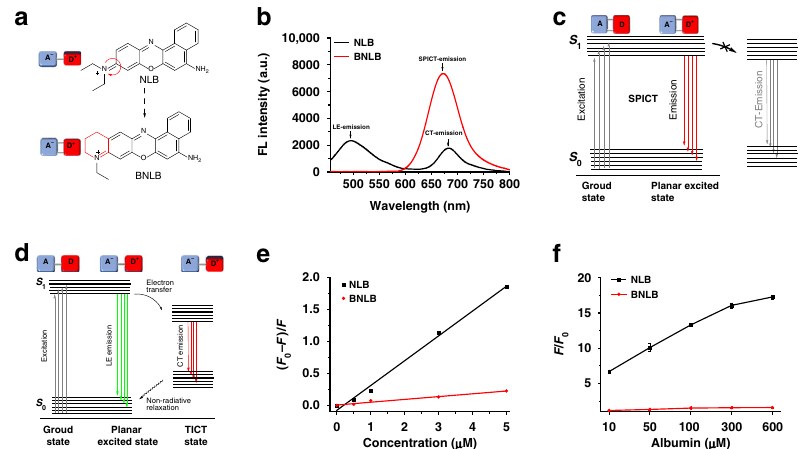
Fig. 3 Design of “ pocket-escaping ” NIR dyes to avoid albumin binding. a The chemical structure of BNLB. b Fluorescence emission of NLB (black) and BNLB (red) in PBS buffer solution (pH 7.4, 10 mM) with an excitation at 420 nm. c , d Jab ł o ń ski diagram showing the emission mechanism of BNLB and NLB. e Binding af fi nities of BNLB (red) and NLB (black) to albumin ( n = 3 independent experiments). f Fluorescence enhancement of NLB (black) and BNLB (red) with the addition of albumin (10 − 600 µ M). Data are represented as mean values± SD ( n = 3 independent experiments). F 0 and F are the fl uorescence intensity at the maximum emission wavelength without and with the presence of analyte, respectively. Source data for Fig. 3e, f are provided as a Source Data fi